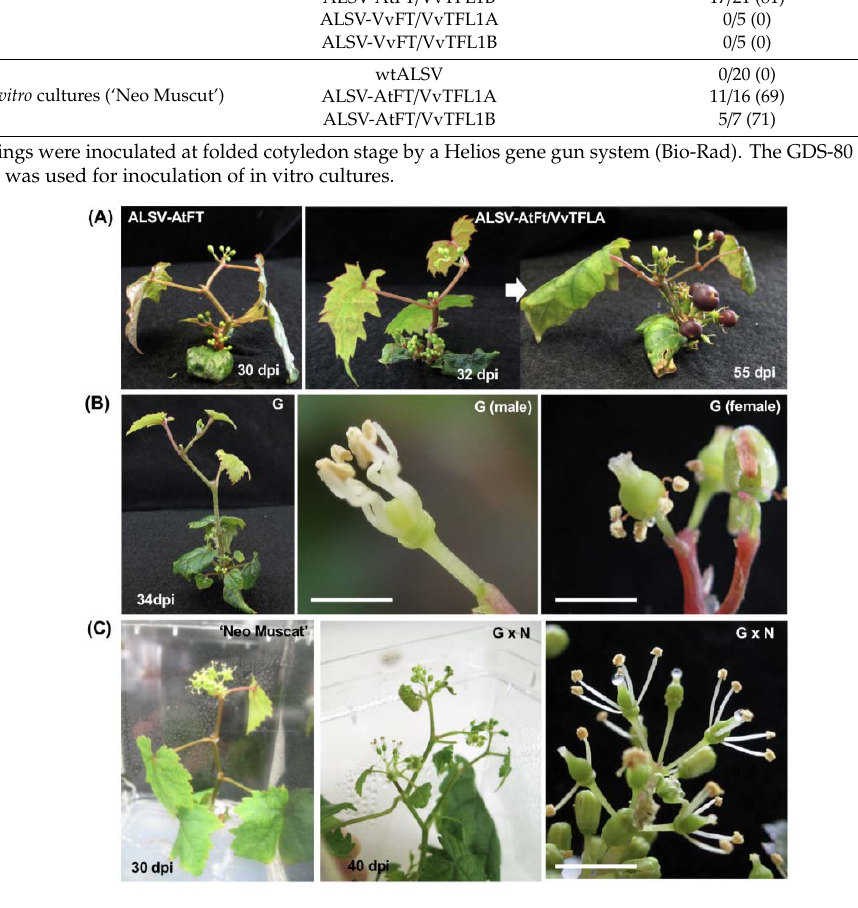
Figure 5. Early flowering of grapevine seedlings and in vitro cultures infected with ALSV-AtFT or ALSV-AtFT / VvTFL1A. ( A ) ‘Koshu’ seedlings inoculated at the ‘folded cotyledons’ stage. Dpi, days post inoculation. ( B ) A Ganebu seedling infected with ALSV-AtFT / VvTFL1A (left). Male (center) and female (right) flowers from Ganebu seedlings infected with ALSV-AtFT / VvTFL1A. Scale bars represent 2 mm. ( C ) Precocious flowering of in vitro cultures of ‘Neo Muscat’ (left) and Ganebu × ‘Nehelescol’ (G × N, line 240-1) (center) inoculated with ALSV-AtFT / VvTFL1A at the true leaf stage. Bisexual flowers from G × N are shown in the right-hand picture. A scale bar represents 5